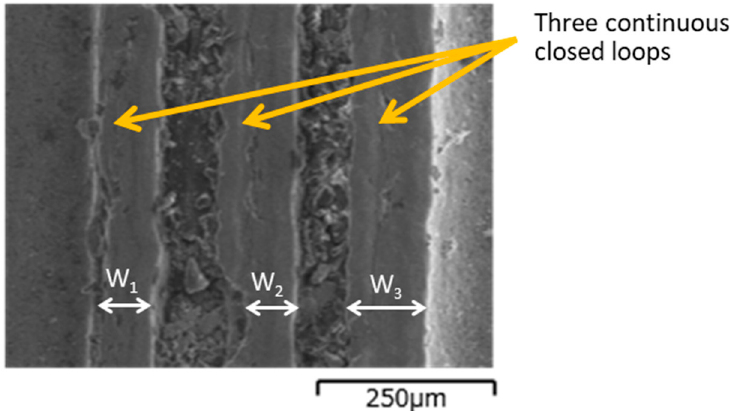
Figure 7. SEM image of the plasma nitrided AISI316 die at 673 K for 14.4 ks before removal of the masks. Three continuous closed loops were seen as three lines and the average width of lines from W 1 to W 3 is 90 µm.